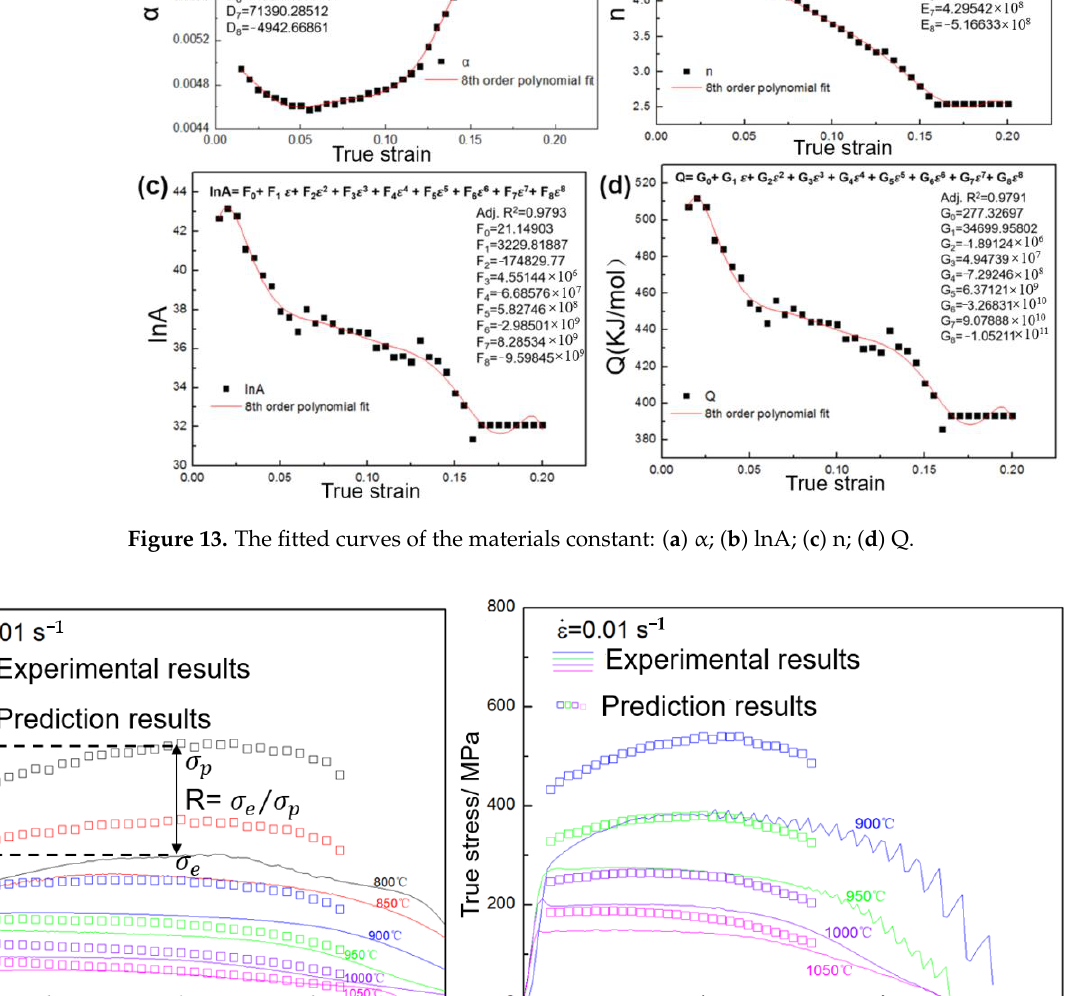
where R is the deviation degree, 𝜎 𝑒 is the maximum value of experiment curve and 𝜎 𝑝 is the maximum value of prediction point. It is obvious that the smaller the R value, the greater the degree of deviation and vice versa.